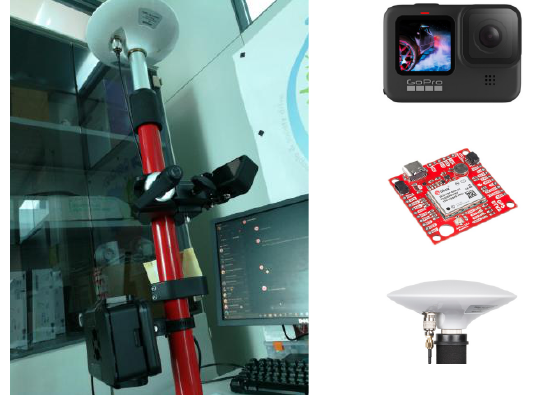
Figure 1: The proposed device (left); the GoPro HERO9 Balck, the SparkFun GPS-RTK2 with the ublox ZED-F9P module and the antenna TOP106 TOPGNSS